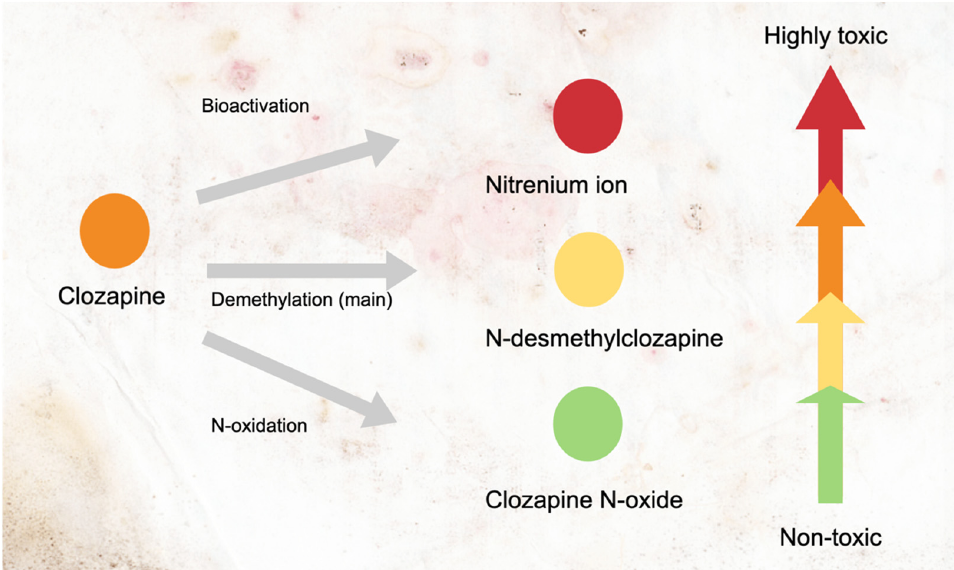
Figure 1. Metabolism of clozapine into metabolites and its cytotoxicity levels. Clozapine is primarily metabolized by cytochrome P450 (CYP) into desmethylclozapine. Another product of CYP metabolism is clozapine N-oxide, a non-toxic and inactive metabolite. Some clozapine is converted into nitrenium ions by hypochlorous acid (HOCI), the oxidant found in the activated neutrophils. The arrows with colors indicate the cytotoxicity levels of each compound in increasing order.